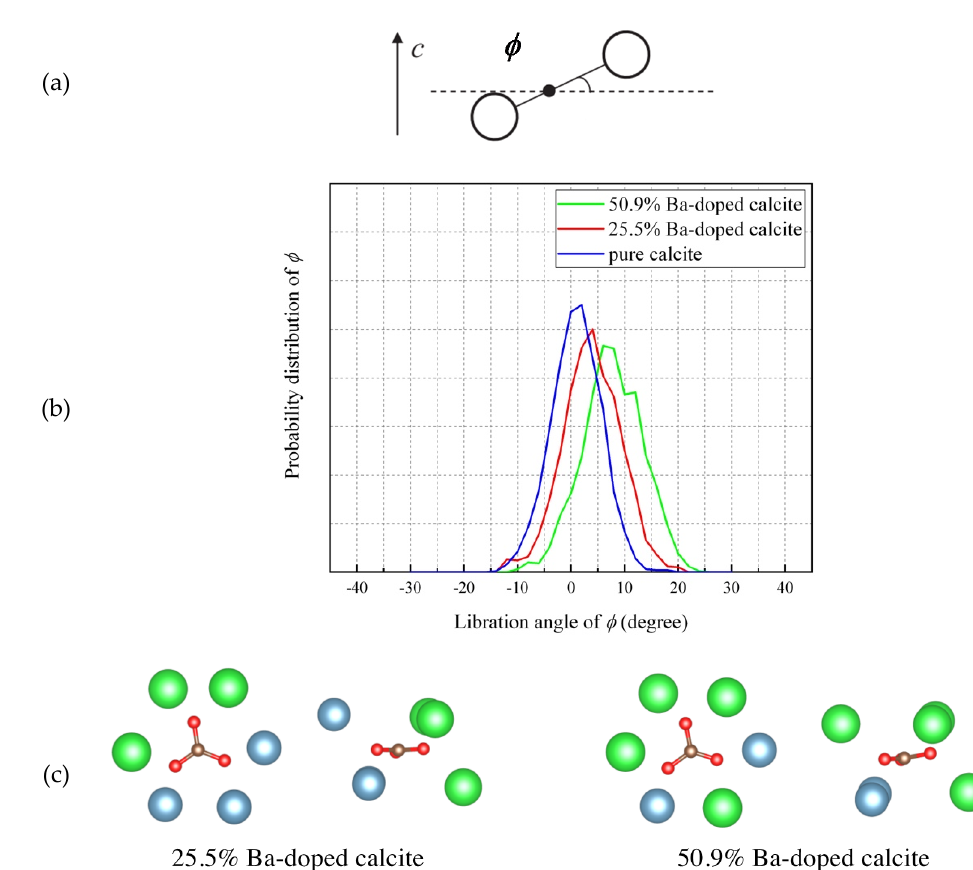
Figure 8. Probability distributions of rotation angle (  ) of one CO 32− ion between the C–O bonds and the a -axis for CaCO 3 , Ca 0.5 Ba 0.5 CO 3 , and Ca 0.5 Ba 0.5 CO 3 at 300 K.